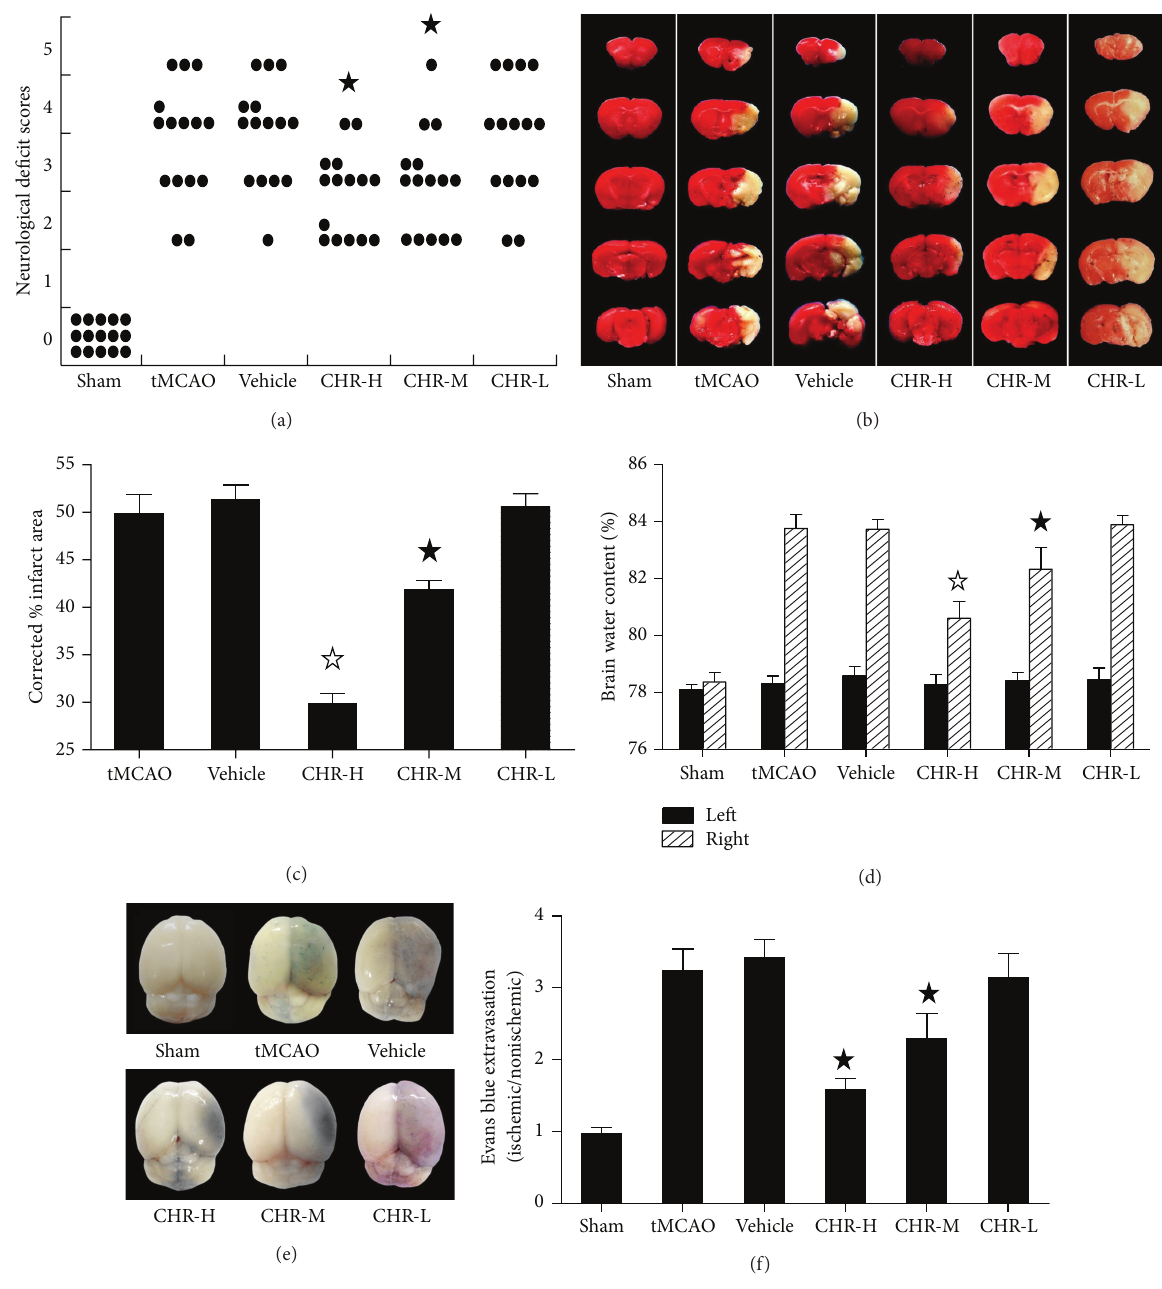
Figure 5: Effect of CHR on neurological deficit. The behavioral scores were significant reduced ( 󳀅 𝑃 < 0.05 versus tMCAO and Vehicle, Mann-Whitney U test) (a). The infarct volume was reduced ( f 𝑃 < 0.05 versus tMCAO, Vehicle and CHR-M, 󳀅 𝑃 < 0.05 versus tMCAO and Vehicle) (b, c). The water content of ischemic hemisphere was reduced ( f 𝑃 < 0.05 versus tMCAO, Vehicle and CHR-M, 󳀅 𝑃 < 0.05 versus tMCAO and Vehicle) (d). BBB permeability was ameliorated (󳀅 𝑃 < 0.05 versus tMCAO and Vehicle) (e, f).